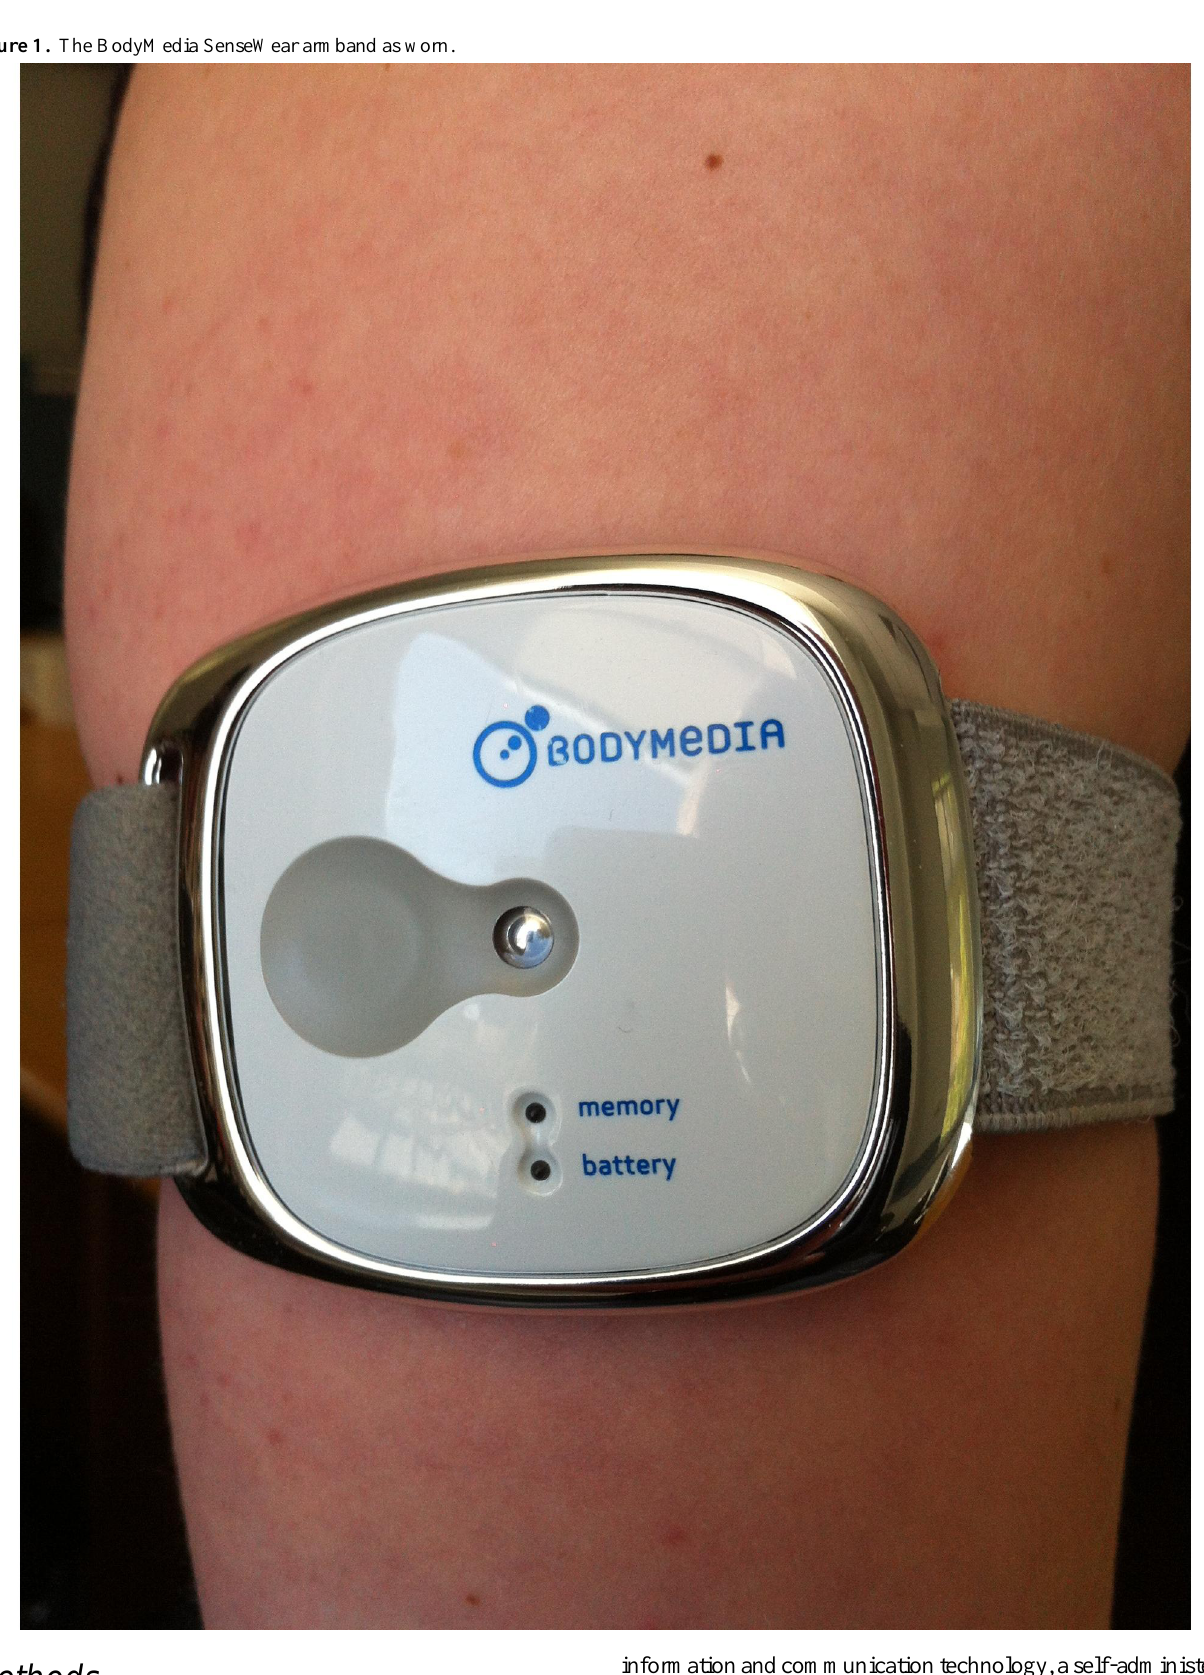
Figure 1. The BodyMedia SenseWear armband as